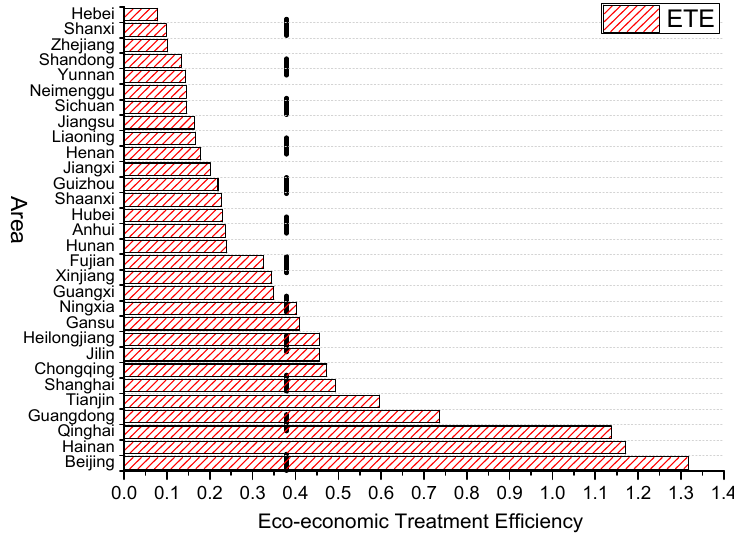
Figure 1. Average value of regional eco-economic treatment efficiency in China (2009–2016).